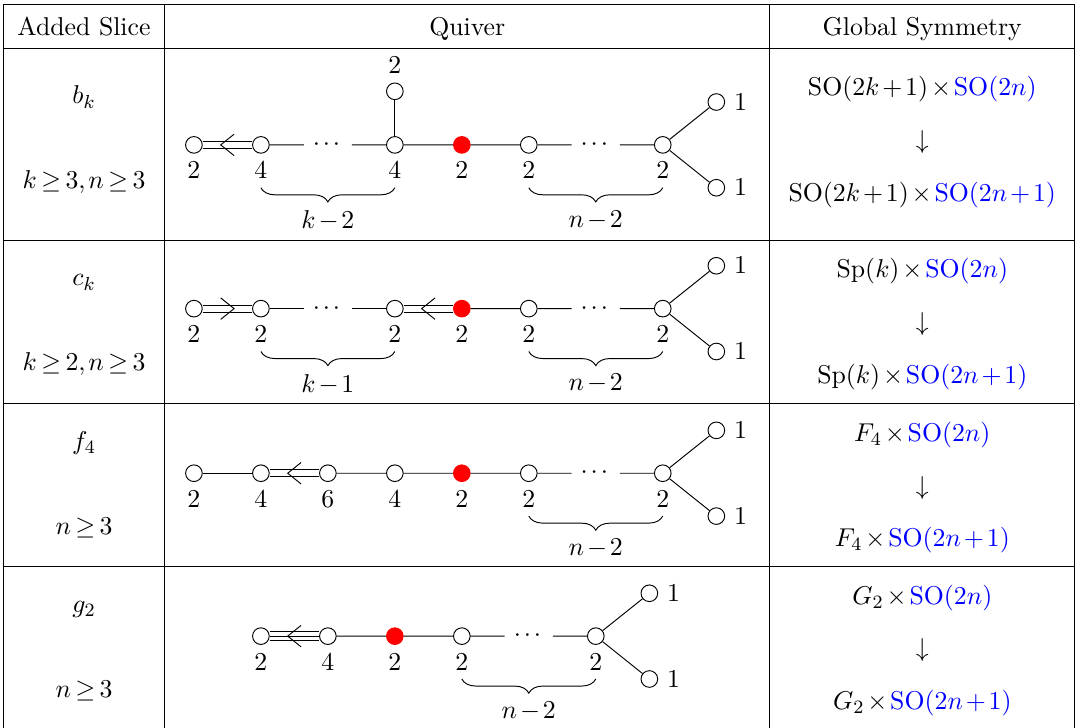
Table 9 . Quivers resulting from adding all possible non-simply laced elementary slices to the empty nodes of n.min B (4.1) to absorb a , n ≥ 3 n